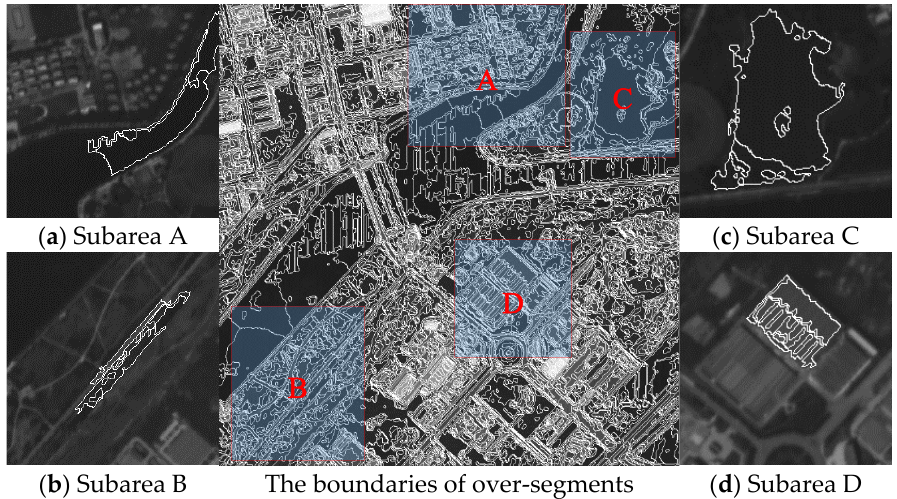
Figure 9. The boundaries of over-segments obtained by using the EDCRP from the experimental image. The subfigures ( a – d ) are zoomed results from subareas A, B, C, and D, respectively.